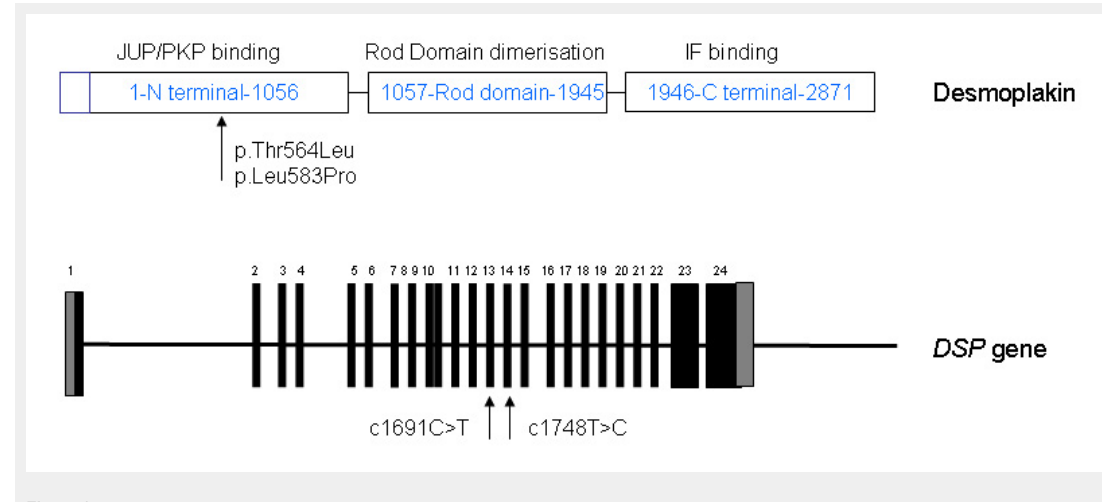
Figure 3 Structural organisation of desmoplakin and the desmoplakin gene ( DSP ). Desmoplakin, a big molecule (2871 AA) composed of three domains, is a critical protein of the desmosomal junction that serves to anchor the cytoskeleton to the plasma membrane. Desmoplakin exists in two isoforms: the longer desmoplakin I and the shorter desmoplakin II which is not expressed in the